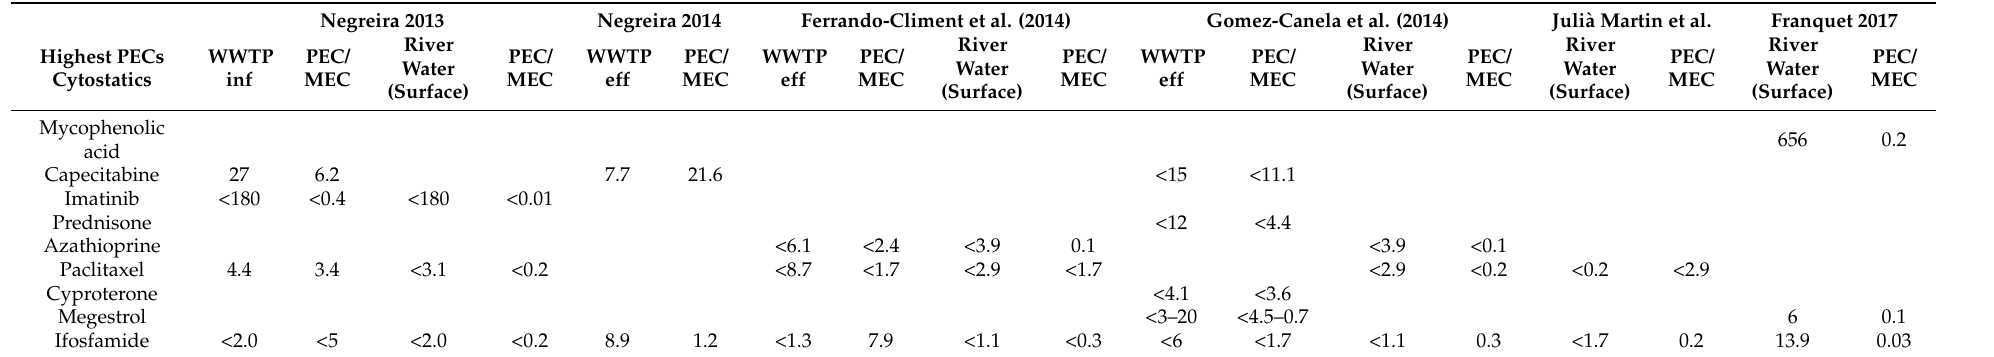
Table 3. Concentration of cytostatic drugs published in the literature (ng L − 1 ). PECs vs. MECs ratios. Negreira 2013 Negreira 2014 Ferrando-Climent et al. (2014) Gomez-Canela et al. (2014) Juli à Martin et al. Franquet